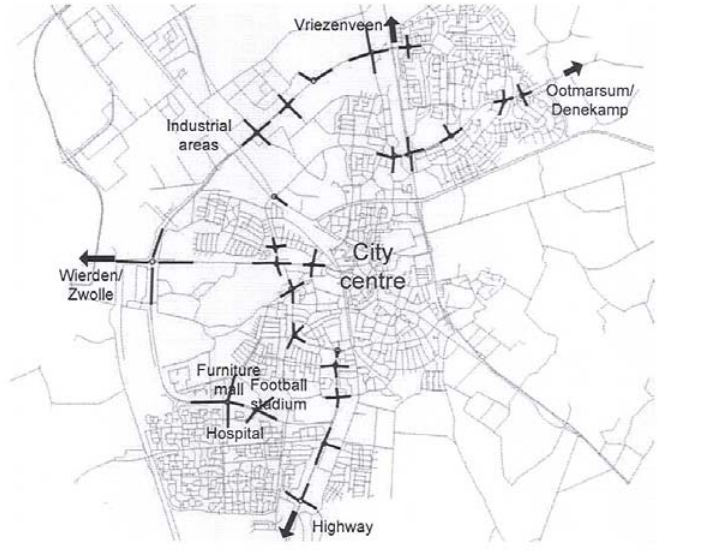
Figure 1. The city of Almelo. Note: The thick lines correspond with intersection links for which traffic data were